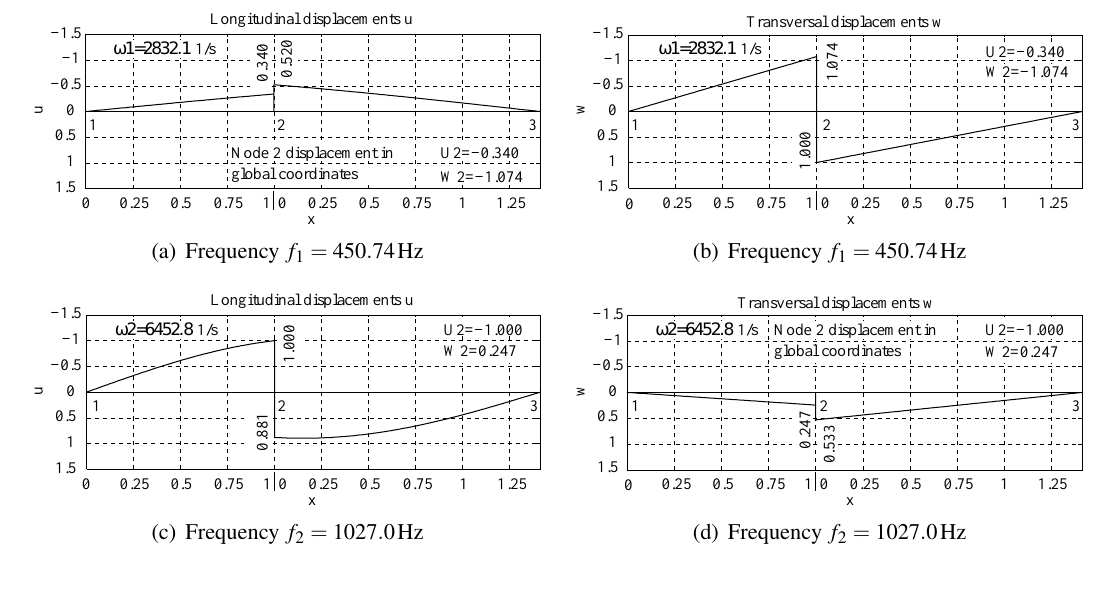
Fig. 9. Natural modes of a truss structure. ( Continued on the next page.